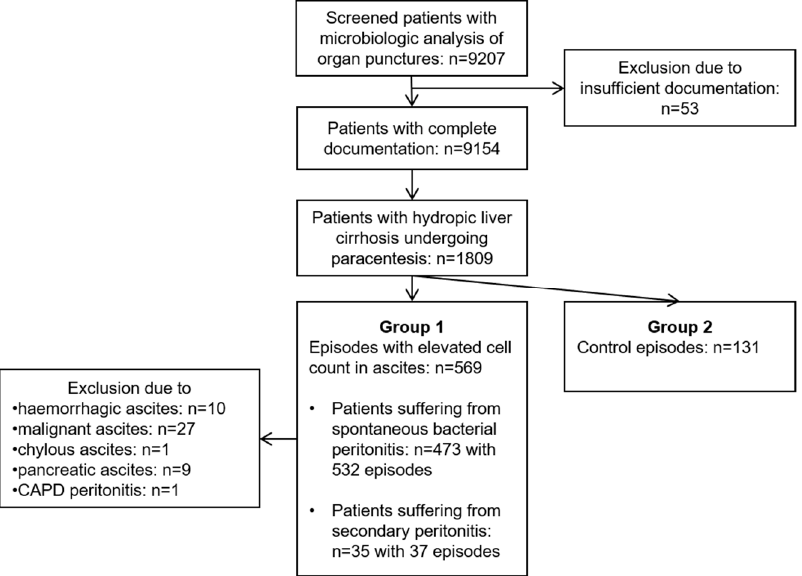
Figure 2. Flow chart of the screening and eligibility process of the study. An elevated cell count in ascites (group A) was defined by ≥ 250 polymorphonuclear leukocytes/mm 3 and/or a leukocyte count ≥ 500/mm 3 . CAPD, continuous ambulatory peritoneal dialysis.